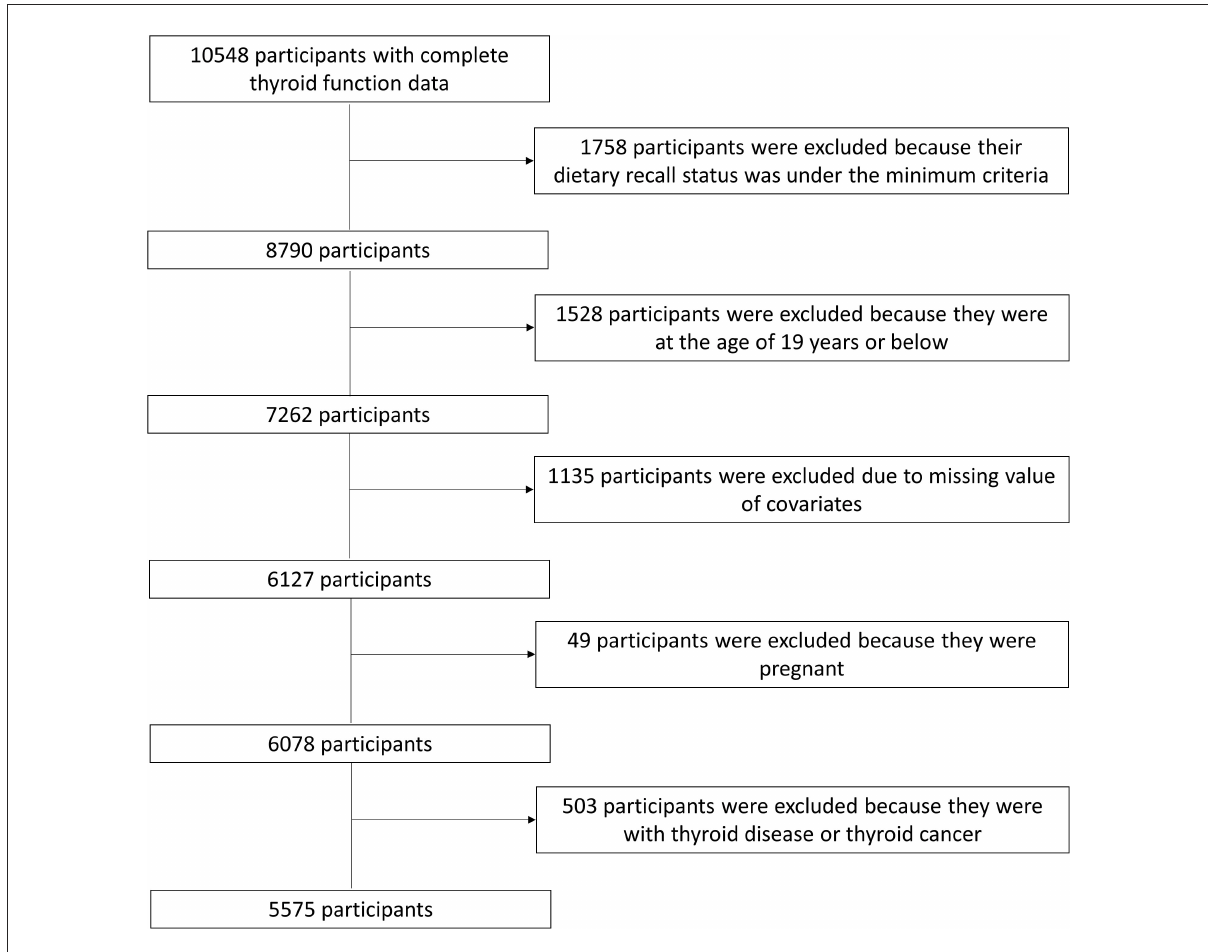
FIGURE1 Flowchart of the study population.